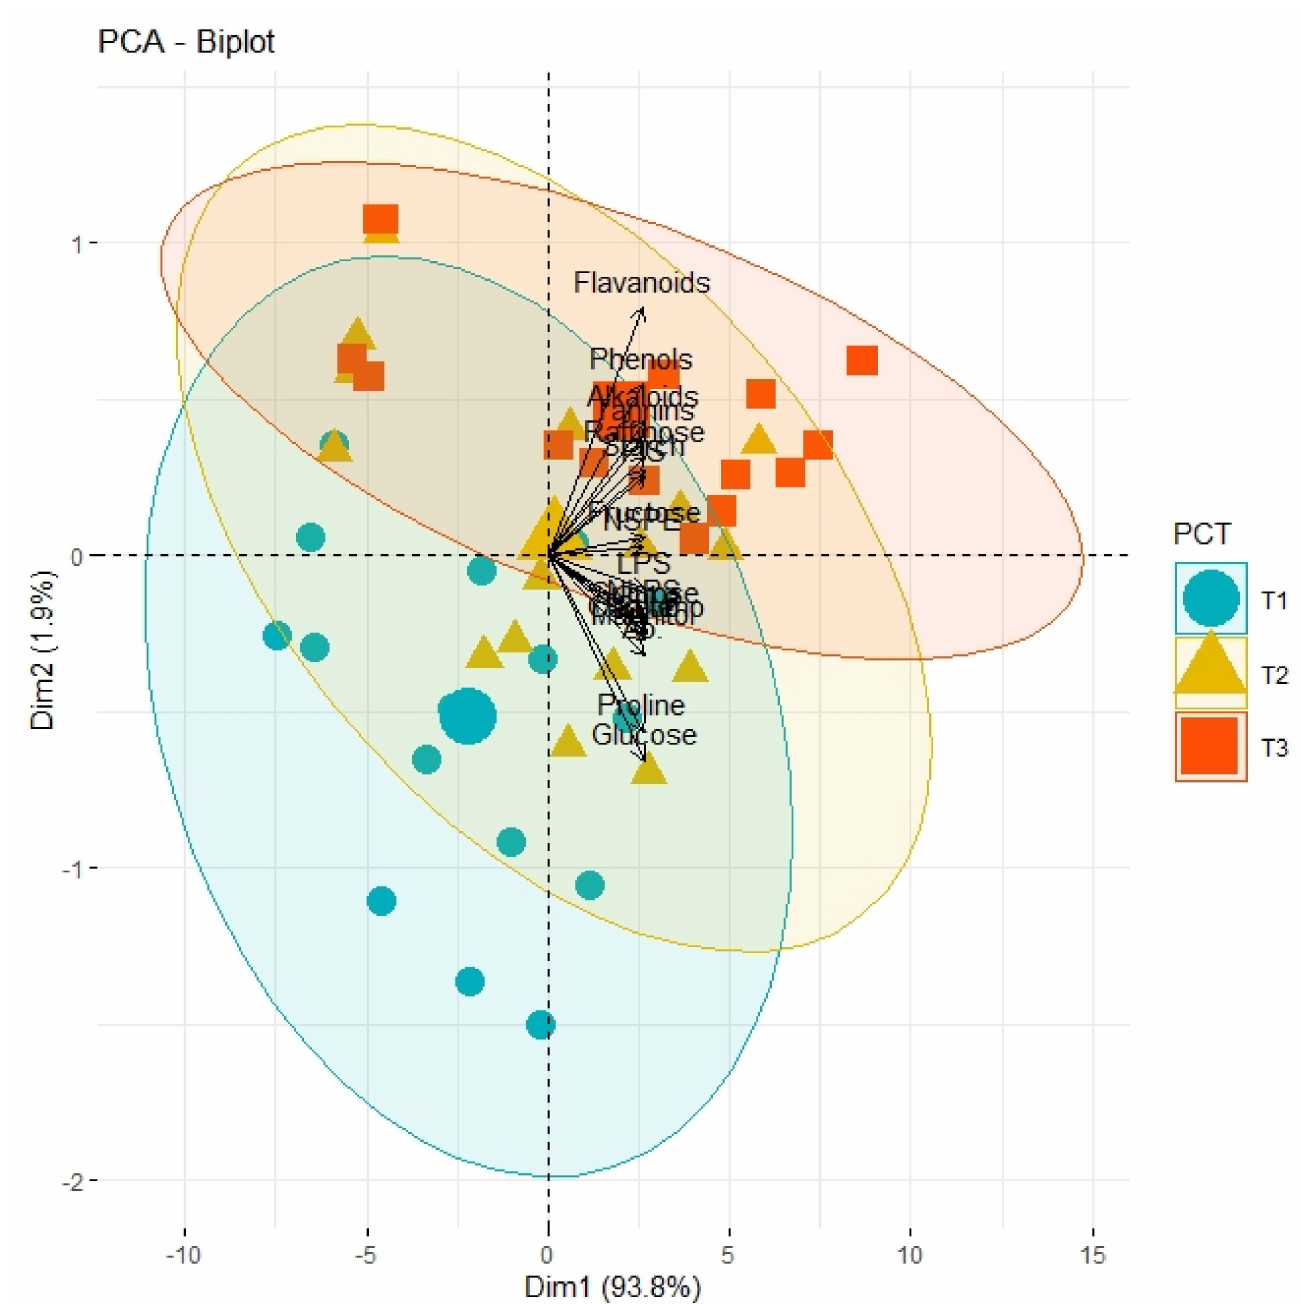
Figure 2. PCA graph demonstrating the extent of association and divergence of physiological, biochemical, and growth-related traits of different olive genotypes from origin under varying pre- cooling treatments (T1, control; T2, 24 h; T3, 48